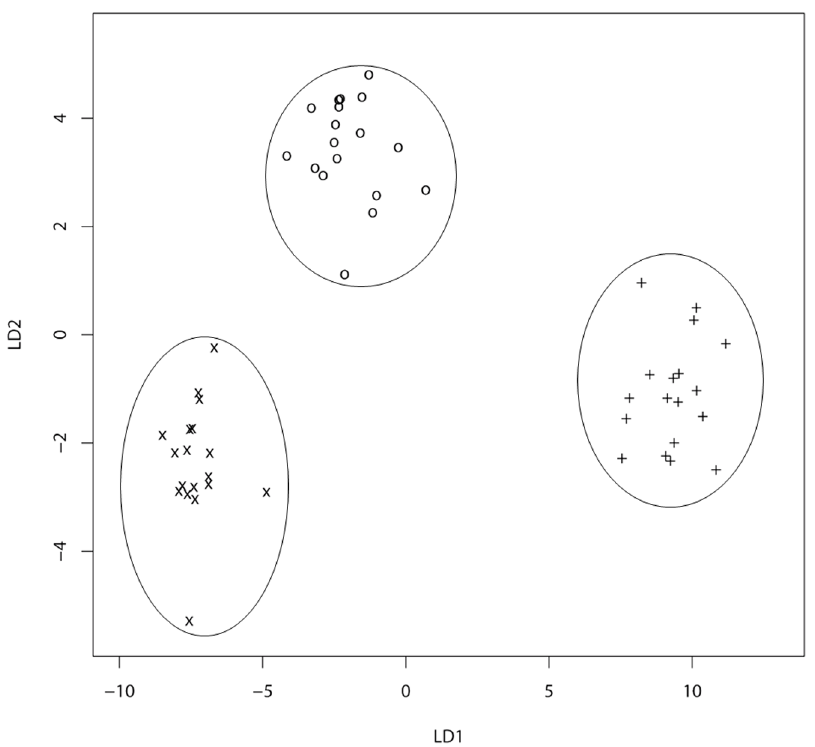
Fig. 3. Host imprint on mice passaged L. monocytogenes isolates monitored be FTIR spectroscopy. LDA was carried out on second derivative, vector-normalized FTIR spectra from L. monocytogenes re- isolated from challenged 129/Sv (X), Tyk2 2 / 2 (O) and C57BL/6 ( + ) mice derived from the two independent experiments.